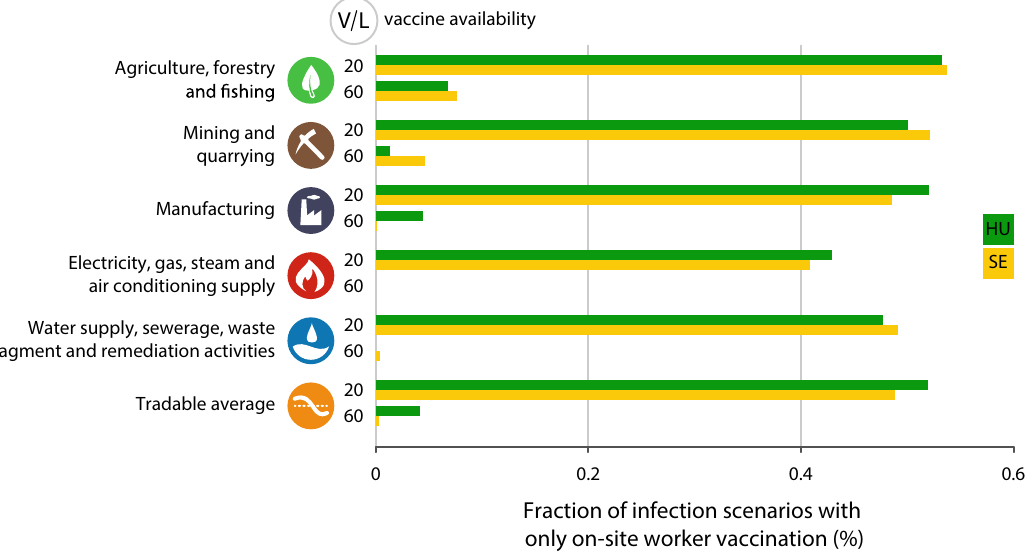
Figure 4. On-site worker vaccination saves jobs in the tradable sector. V / L denotes vaccine availability for 20–60% of all employees. Percentage values represent the share of infection scenarios when on-site workers shall receive all of the available vaccines to save the most